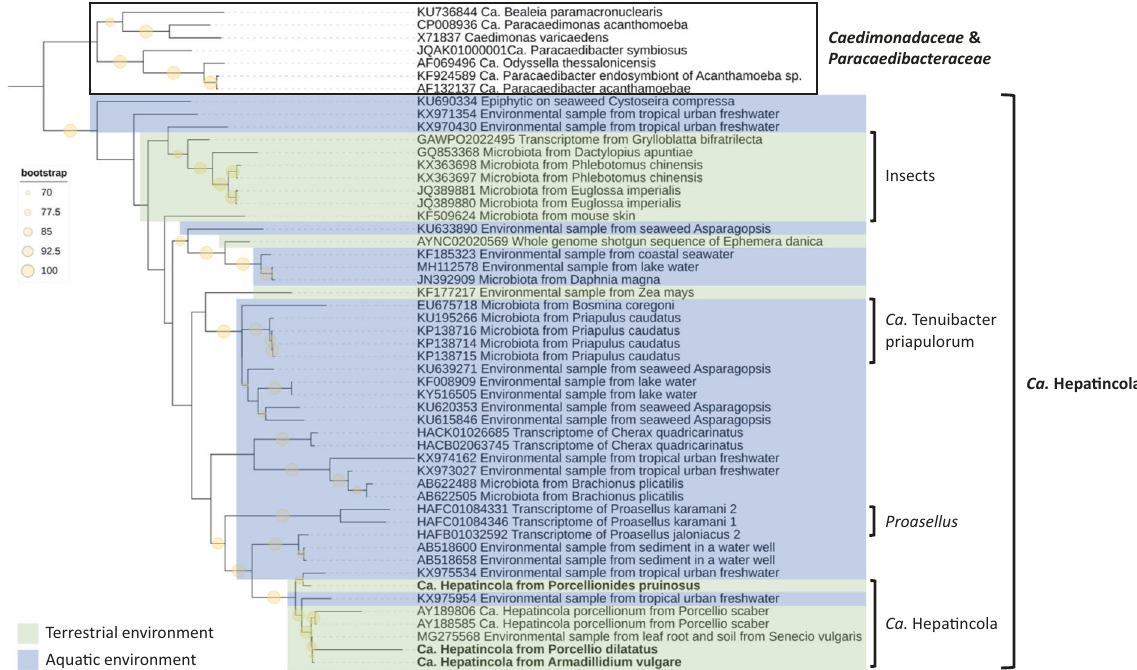
Fig. 5 Diversity and environmental distribution of taxa within the family ‘ Ca . Hepatincolaceae ’ . Maximum likelihood tree based on the 16S rRNA gene sequences of 45 taxa assigned to the family ‘ Ca . Hepatincolaceae ’ . Seven strains from the Caedimonadaceae and Paracaedibacteraceae were used as outgroup. Branch support is based on 1000 bootstrap iterations, only bootstraps ≥ 70 are shown. Sequences of aquatic origin are highlighted in blue, those of terrestrial origin in green. The 16S rRNA gene sequences from the three Hepatincola genomes are indicated in bold.